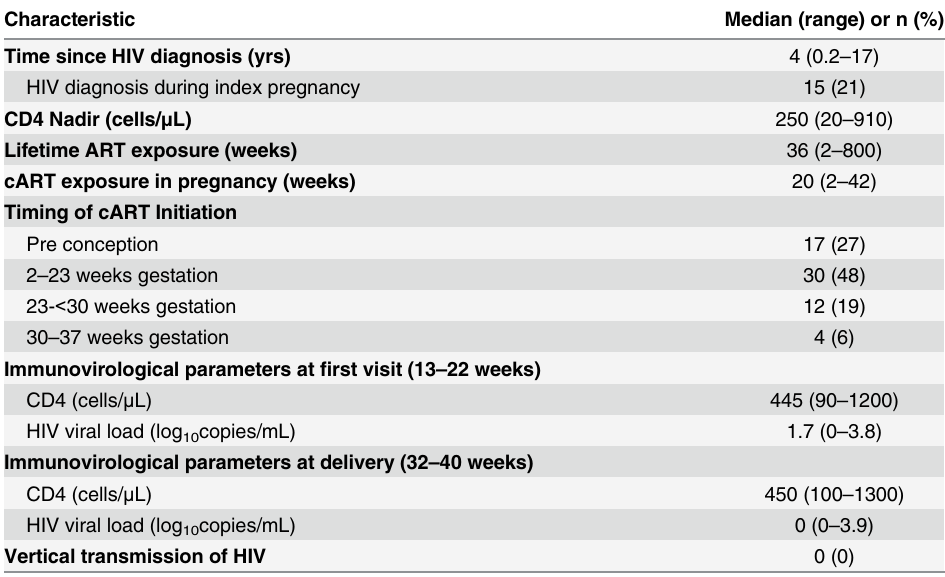
Table 2. HIV-specific clinical characteristics of HIV+ cohort (n =